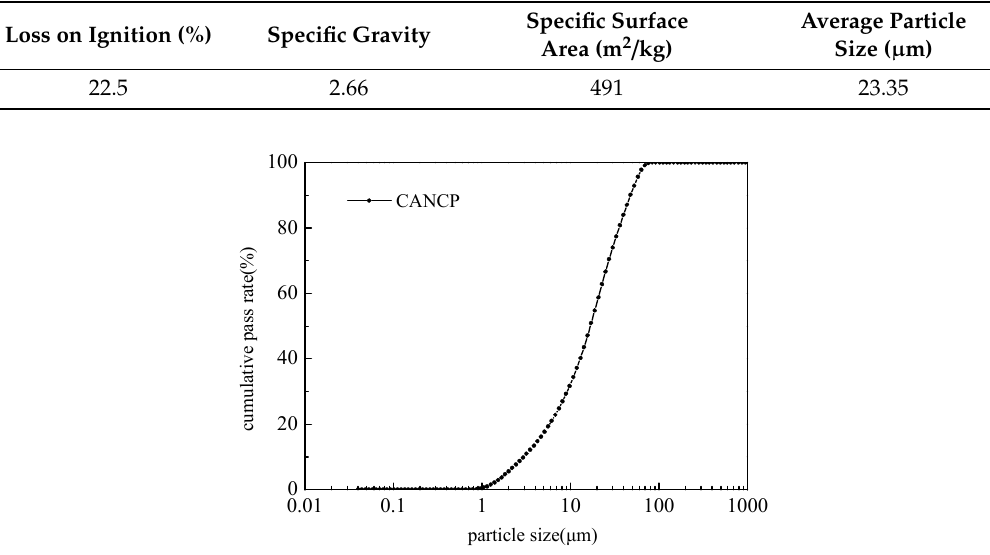
Table 6. Physical properties of CANCP.